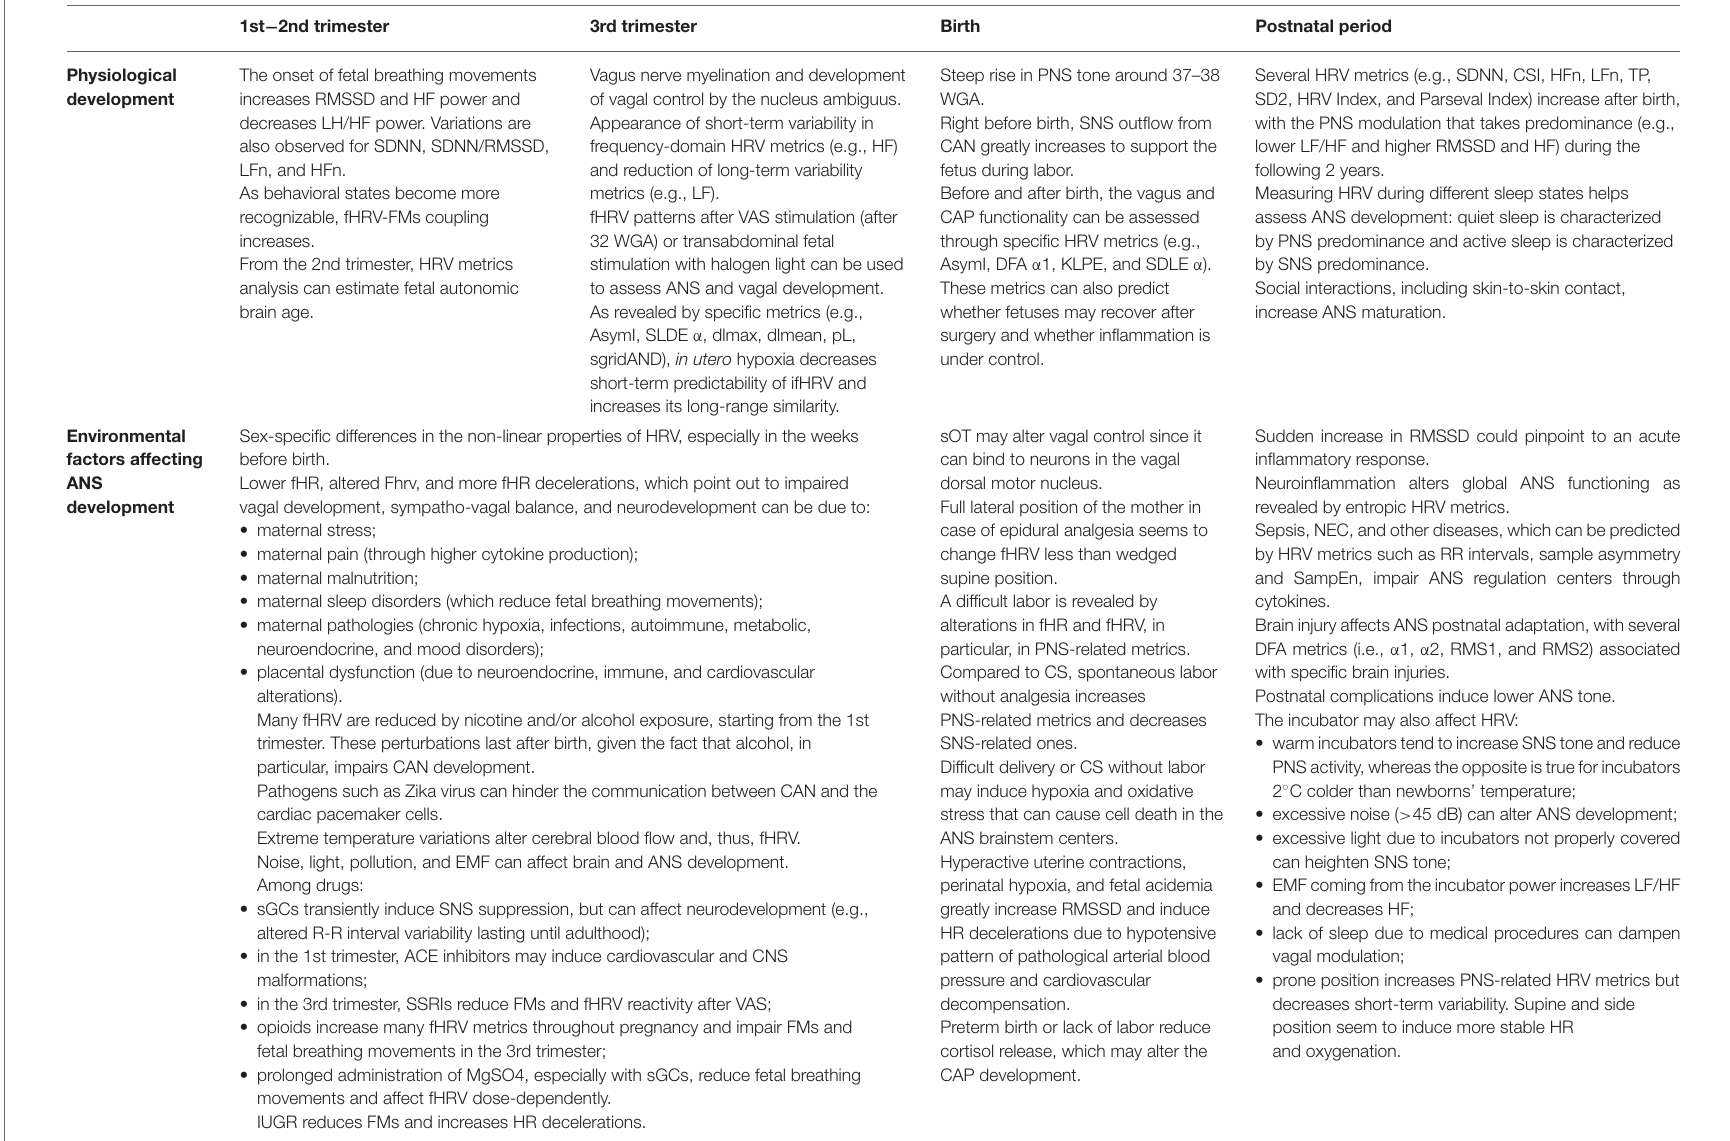
TABLE 2 | Summary of the finding of the present review regarding ANS development and HRV. 1st − 2nd trimester 3rd trimester Birth Postnatal